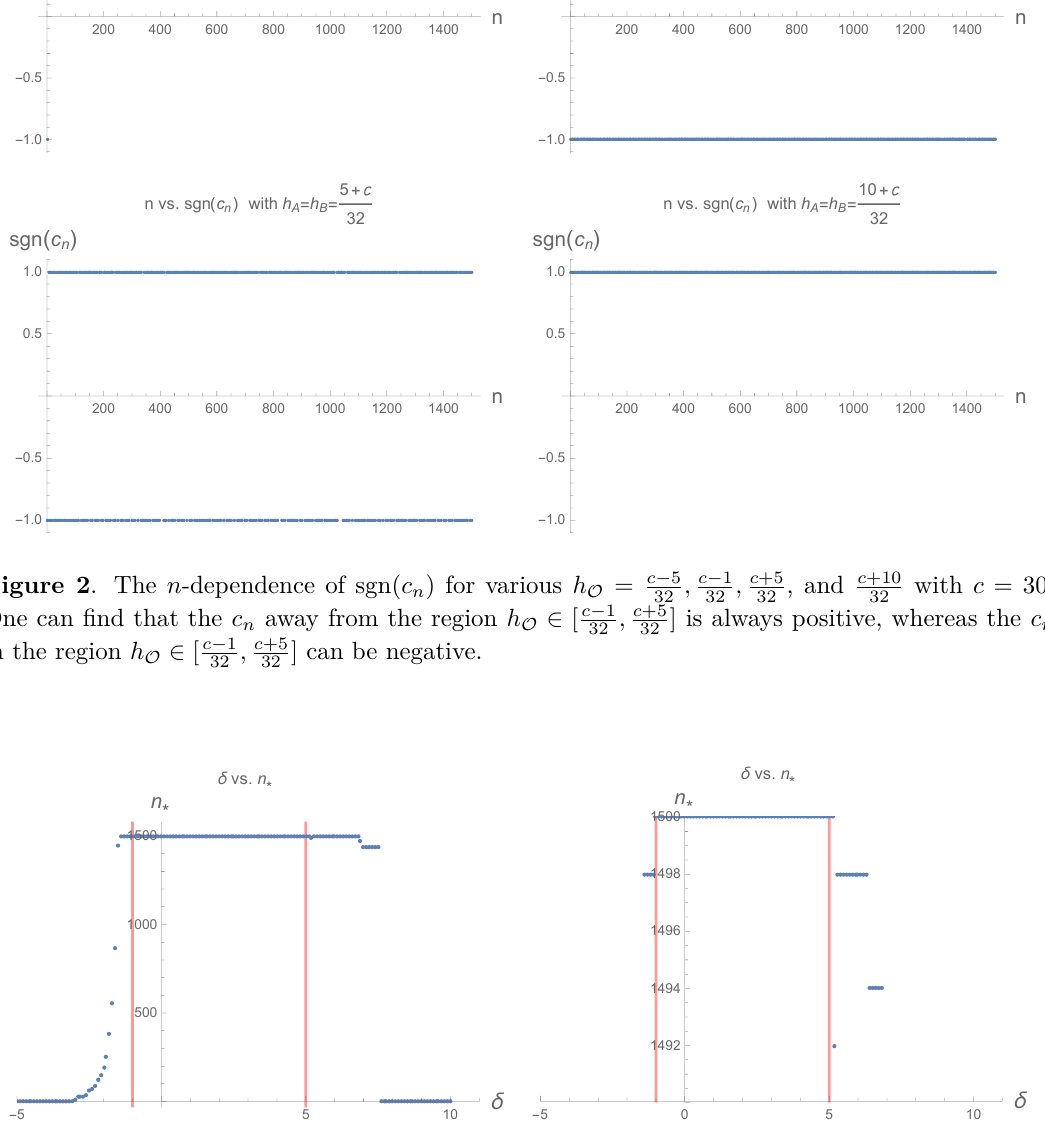
< 0 . The red lines show the ∗ ≡ h . The right figure is the zoomed 32